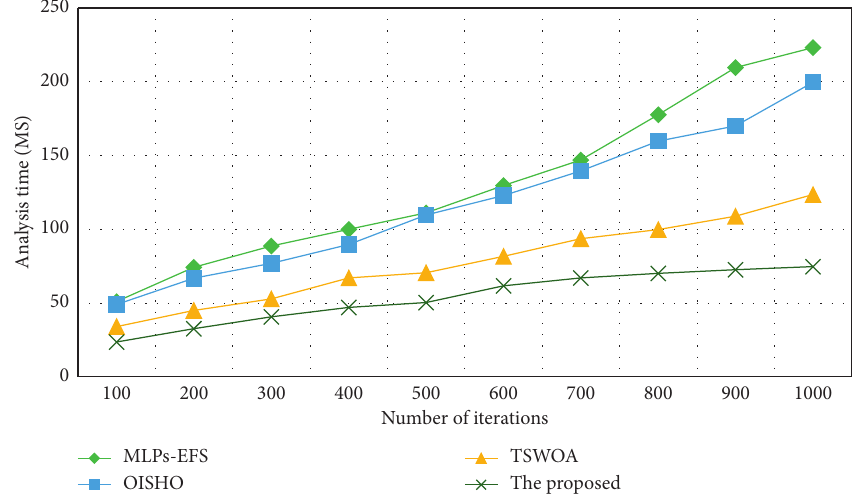
Figure 5: Results of analysis